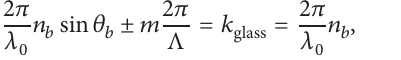
Random arranged PS Figure 3(a) patterns with obvious defects Single- or multilayered PS Figure 3(b) Single-layered Figures 3(c) and 3(d)